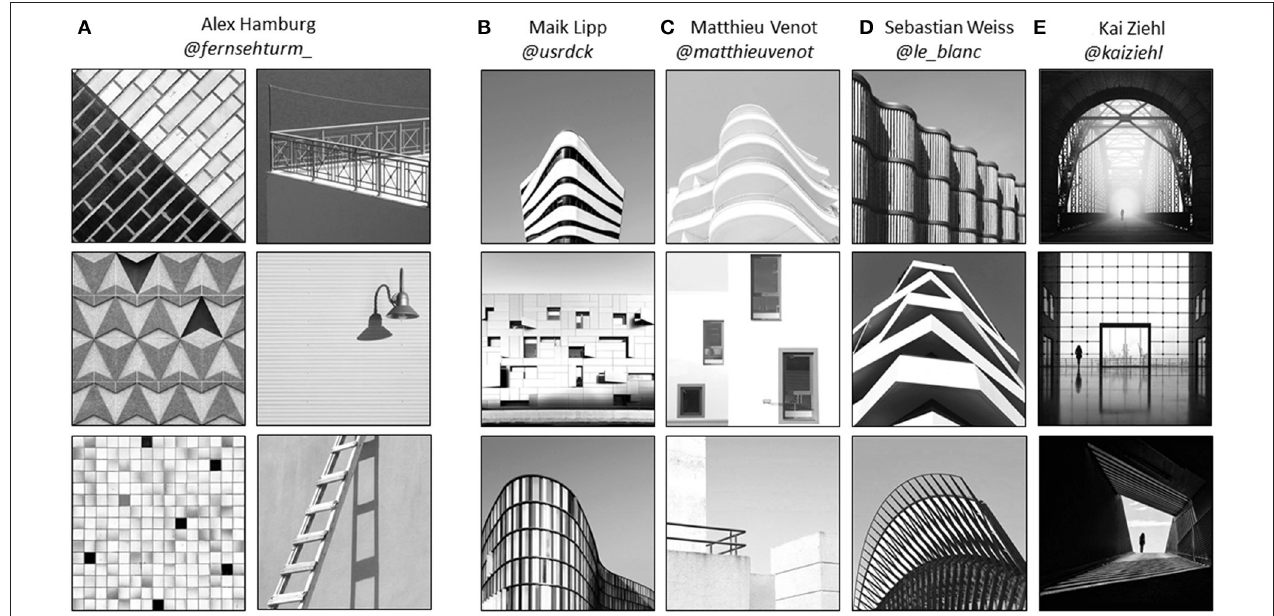
FIGURE 3 | Example photographs included in the Instagram database arranged by “2D” vs. “3D” appearance. (A) Three examples of “2D” compositions: rotation-invariant close-ups. Three examples of Alex Hamburg’s 3D compositions: not fullfilling the strict criterion of rotation-invariance. (B–E) Three examples of “3D” compositions for each photographer: facades of buildings and cityscapes. Note: Only Kai Ziehl originally posts his work in black-and-white, pictures by the other photographers were originally posted in